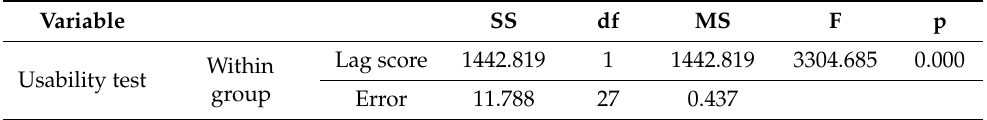
Table 4. Statistical significance of repeated measurement variance